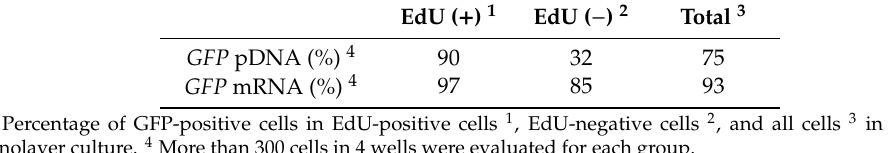
Figure 3. Relationship between GFP expression and cell division in MSCs in monolayer culture. GFP pDNA ( a ) and GFP mRNA ( b ) were added to MSC spheroids, followed by 24 h incubation with EdU. Then, cells were observed with fluorescence microscopy. Green: GFP, Red: EdU, Blue: cell nuclei (Hoechst 33342). Scale bars: 100 μm. Table 2. Percentage of GFP-positive cells in MSCs in monolayer culture.